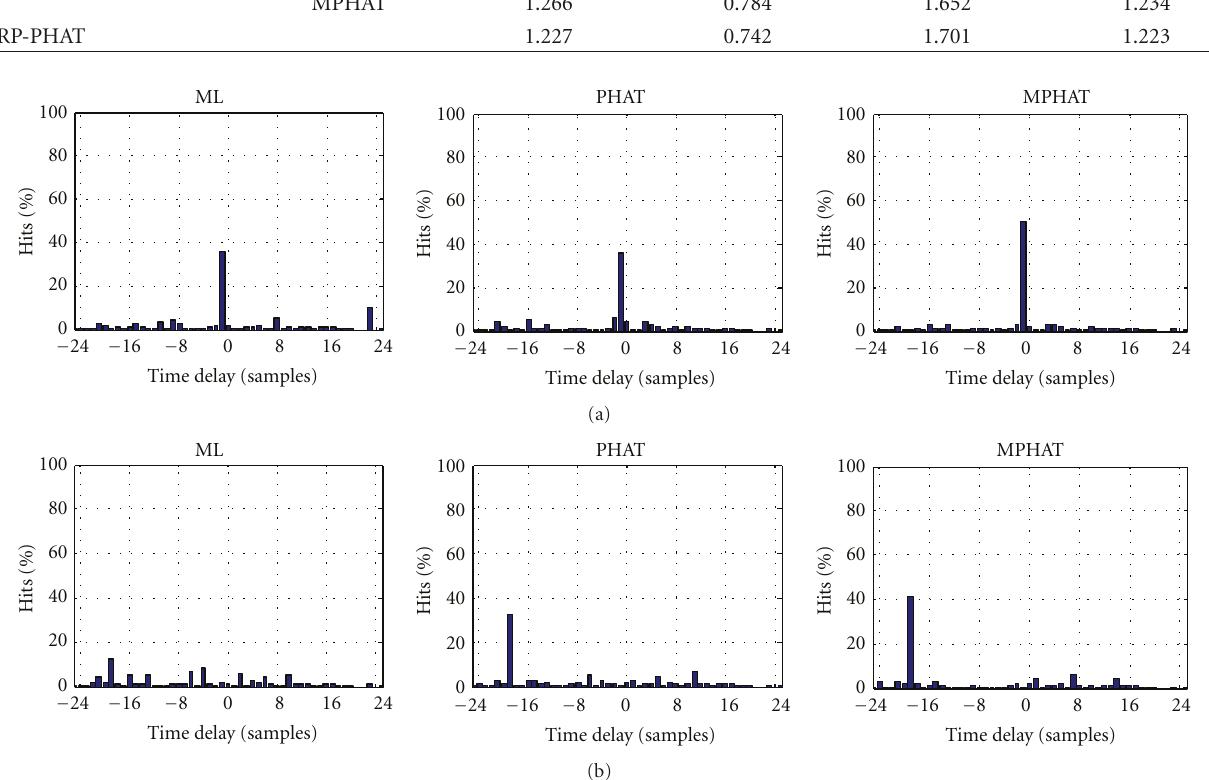
Figure 8: TDE performance in real acoustic environment (a) near speaker (exact value of TDOA is ( − 1) samples), (b) far speaker (exact value of TDOA is ( − 19)